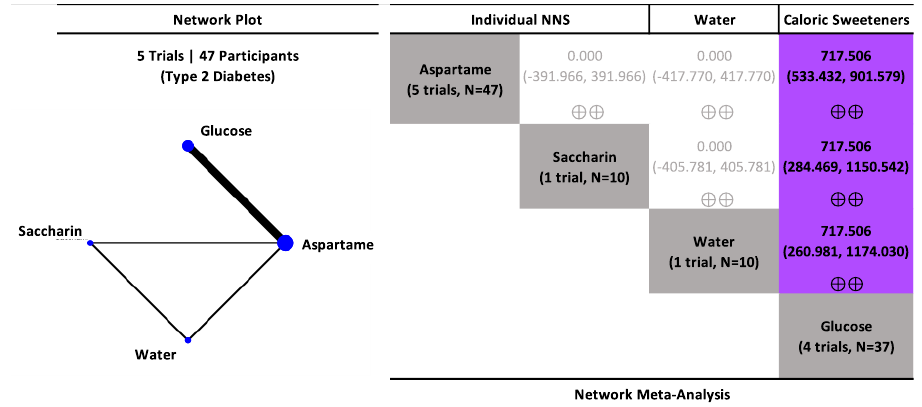
Figure 2. Network plot and meta-analysis of uncoupling interventions evaluating the effect of non-nutritive sweetened beverages (NNS beverages) sweetened single or blends of non-nutritive sweeteners (NNS), water, and sugar-sweetened beverages (SSBs) sweetened with caloric sweeteners on postprandial blood glucose response in participants with type 2 diabetes. Network plot: the size of the blue nodes is proportional to the number of participants and the line width is proportional to the number of studies. Network table: treatments are grouped by treatment type (i.e., individual non-nutritive sweeteners (NNS), NNS blends, water, and caloric sweeteners) and are reported in alphabetical order. Treatment estimates (mmol*min/L) are MDs and 95% CIs of the column-defining treatment compared with the row-defining treatment. MDs less than 0 favor the column-defining treatment. MDs greater than 0 favor the row-defining treatment. Significant results are bolded in black. Non-significant results are grey and not bolded. The minimally important difference (MID) for postprandial glucose response is 100 mmol*min/L. Trivial (significant) effects (<1 MID) or no effects have a white background; small important effects ( ≥ 1 MID) have a light blue background; moderate effects ( ≥ 2 MID) have a darker blue background; large effects ( ≥ 5 to <10 MID) have a purple background; and very large effects ( ≥ 10 MID) have a black background. Confidence in the effect estimate is shown for each treatment comparison: high confidence ⊕⊕⊕⊕ ; moderate confidence ⊕⊕⊕ ; low confidence ⊕⊕ ; and very low confidence ⊕ . See Supplementary Table S7 and Figures S10–S13 for detailed assessments of the confidence in the effect estimate using the CINeMA